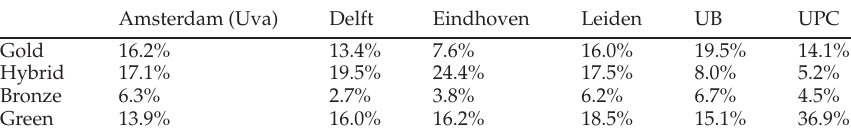
Table 6: Percentages of open access for articles published in 2017 from UB and UPC in comparison to four Dutch